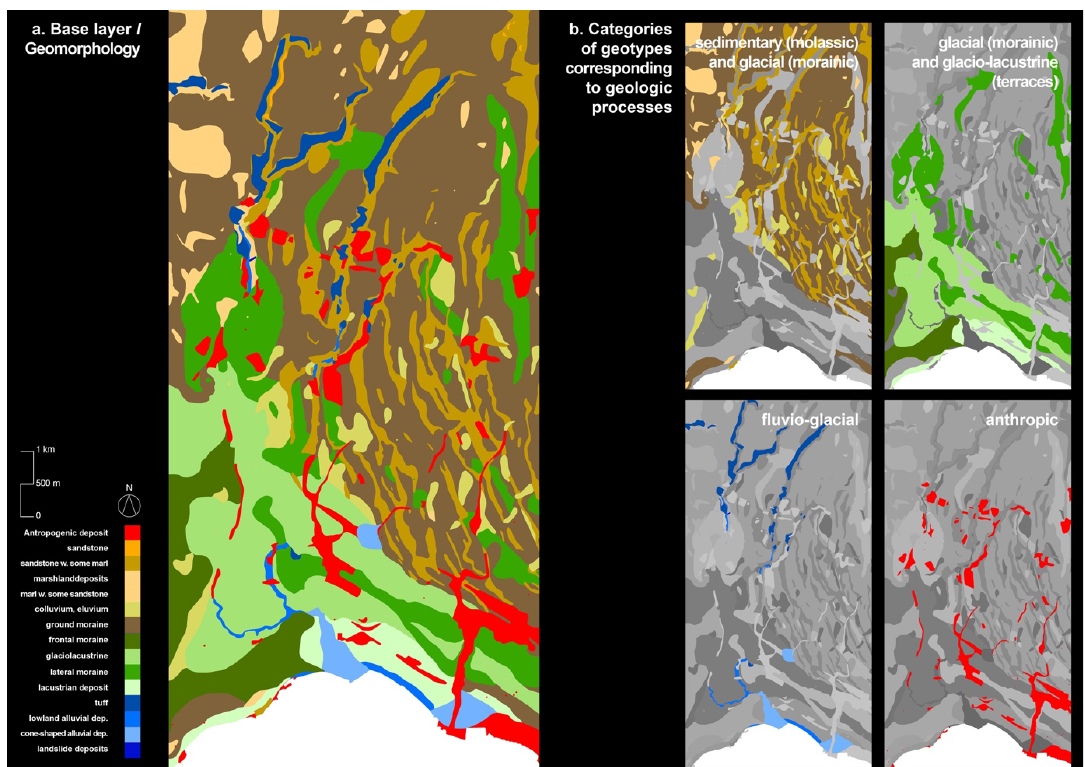
Figure 5. Base layer I. Source: Authors, based on geodata provided by Canton de Vaud–Office de l’information sur le territoire.